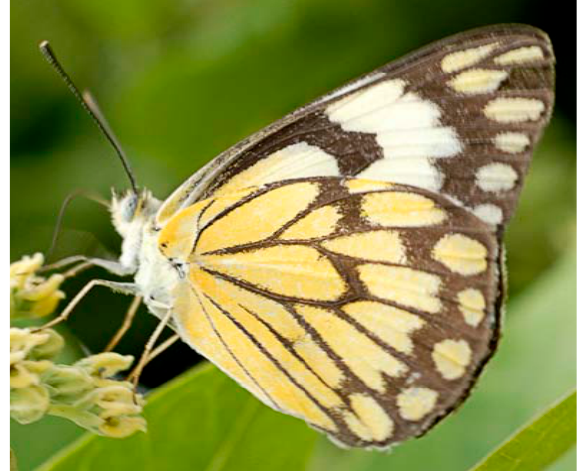
Image 5. Pioneer Anaphaeis aurota